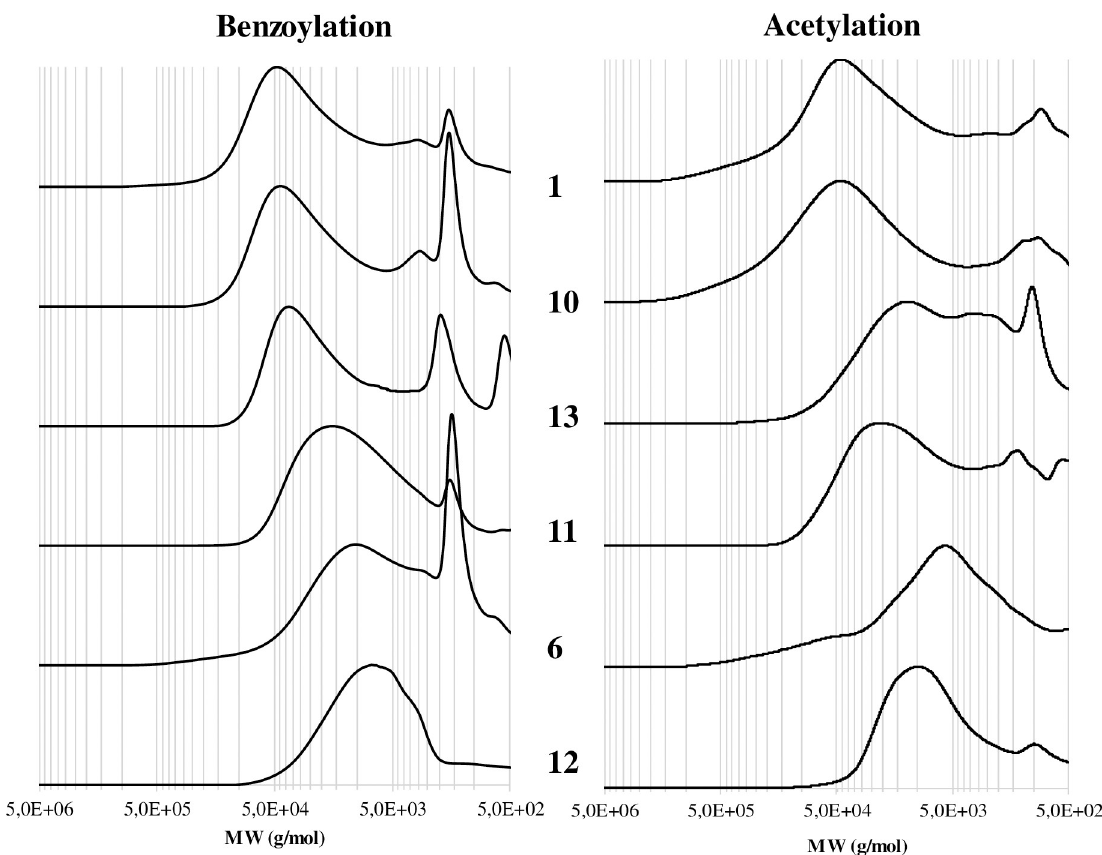
Fig 5. Gel Permeation Chromatography (GPC-UV) profiles (benzoylated on the left at 240 nm, acetylated on the right at 280 nm) for the 1, 10, 13, 11, 6 and 12 woods samples. Y-scale in A.U. normalized.